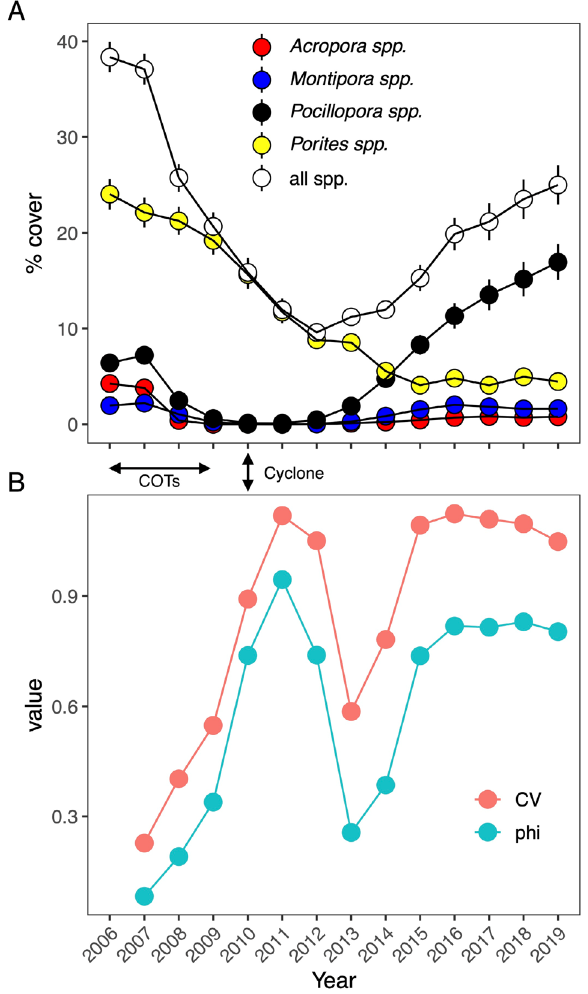
Figure 3. Coral cover from 2006 to 2019 at LTER1, pooled among habitats: ( A ) mean (± SE, n = 4 habitats year −1 , SE bars smaller than symbol size where they are not shown) percent cover of the four most common corals that account for 43–95% of the coral cover in each habitat, and ( B ) synchrony (phi) and community variability (CV) over